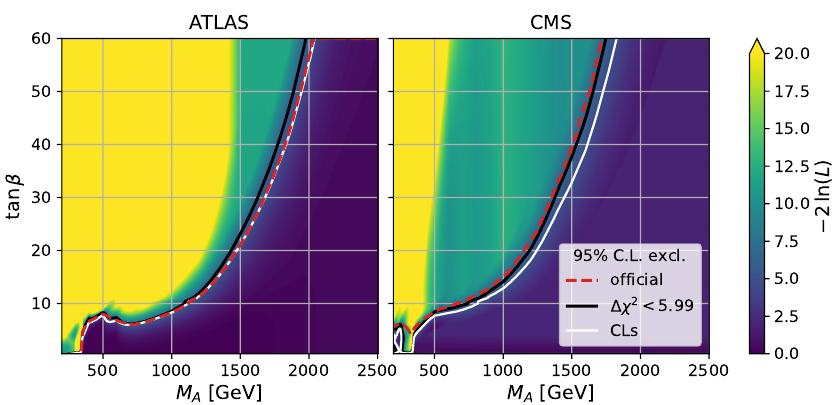
Figure 9: The reconstruction of the CL hood in three independent dimensions of m based on results from ATLAS [ 127 ] and CMS [ 128 ]